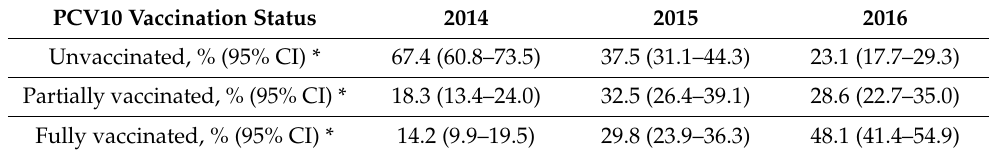
Table 3. Vaccination status across the three surveys in children 3–12 months of age in Matiari.